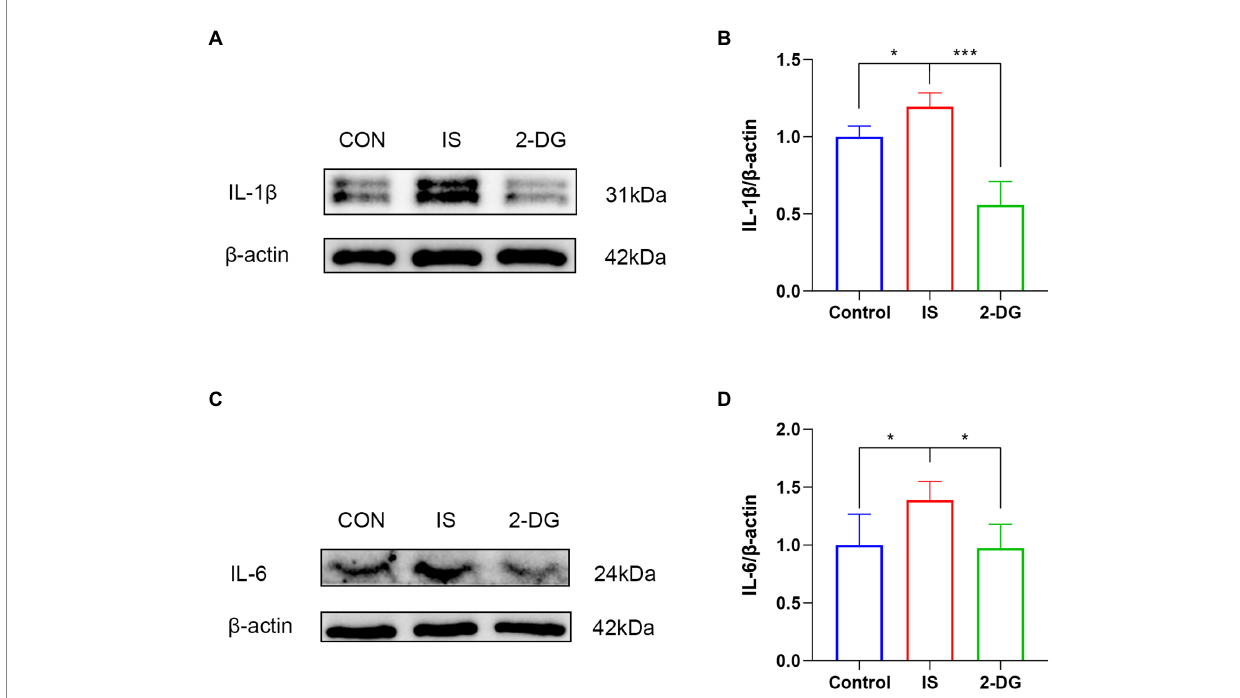
FIGURE 6 2-DG inhibited IS-induced release of pro-inflammatory factors in the medulla dorsal horn. (A) WB of IL-1 β protein in the medullary dorsal horn. (B) Infusion of IS increased IL-1 β protein levels in the medulla dorsal horn, and the expression of IL-1 β was significantly decreased in the 2-DG group compared with the IS group. Data were expressed as mean ± SD ( n = 3 per group). *** p < 0.001, * p < 0.05. (C) WB of IL-6 protein in the medullary dorsal horn. (D) Infusion of IS increased IL-6 protein levels in the medulla dorsal horn, and the expression of IL-6 was significantly decreased in the 2-DG group compared with the IS group. Data were expressed as mean ± SD ( n = 3 per group). * p <